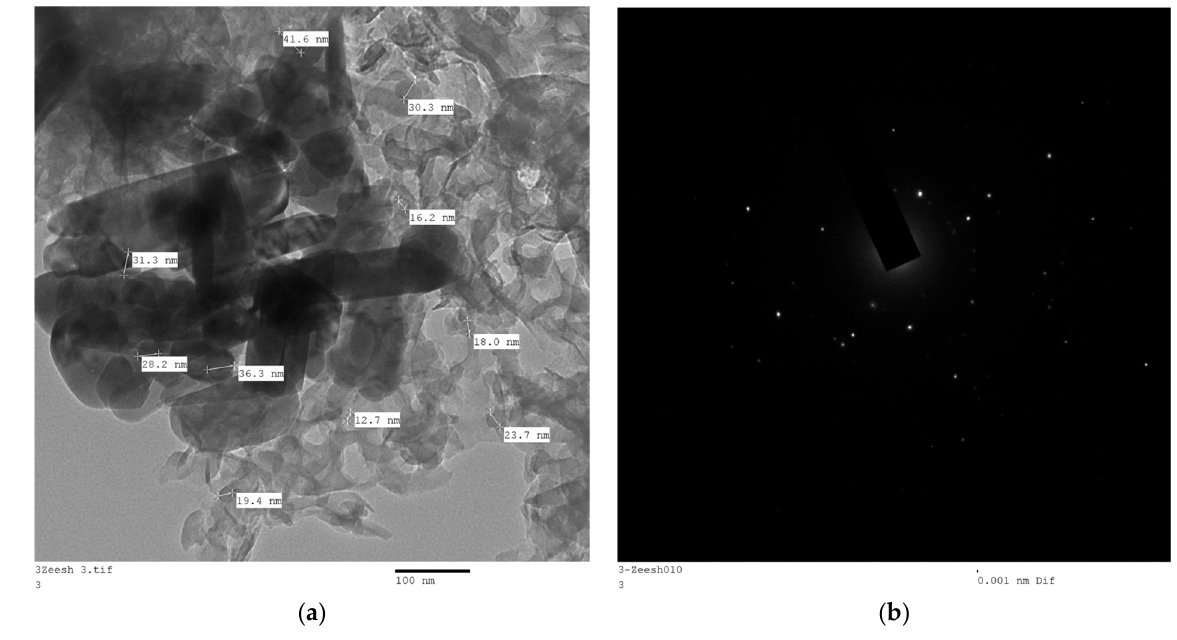
Figure 2. ( a ) TEM image and ( b ) SAED image of AISD.